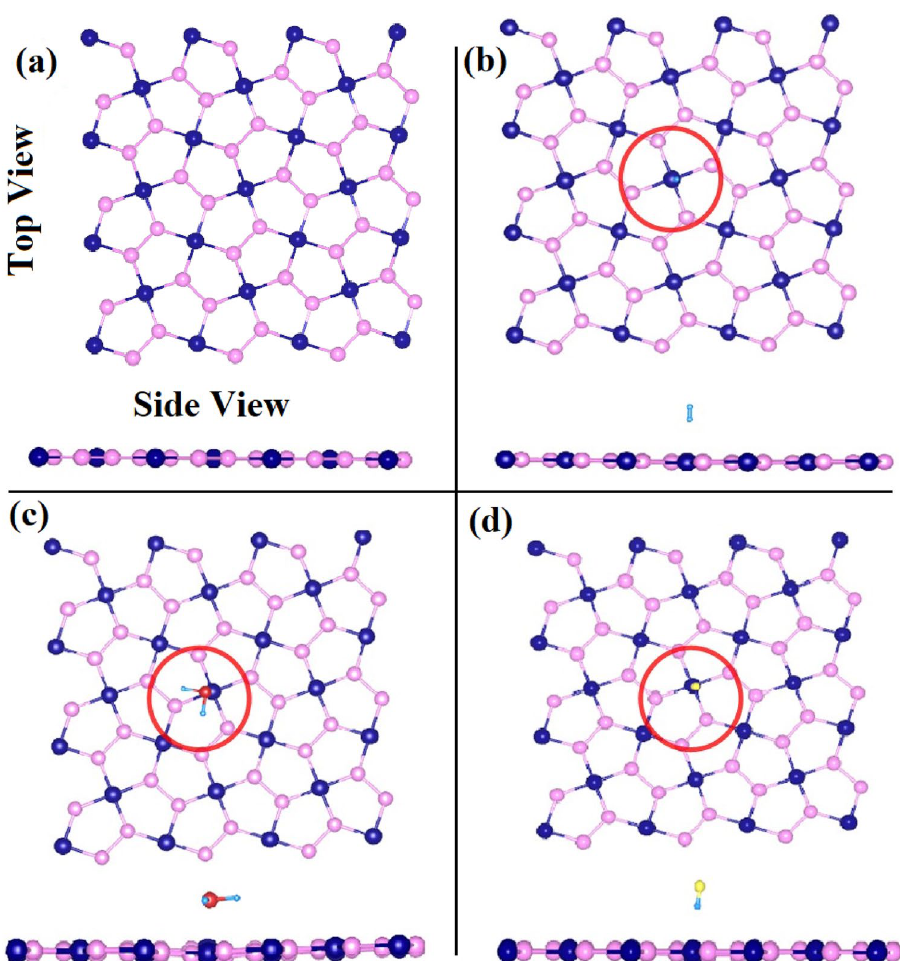
Figure 1. Side and top view of the ( a ) Bare penta-PdAs 2 monolayer and after gas adsorption of ( b ) H 2 ( c ) H 2 S and ( d ) HF. The Pd, As, H, S and F atoms are indicated in navy blue, pink, water blue, red and yellow colors,